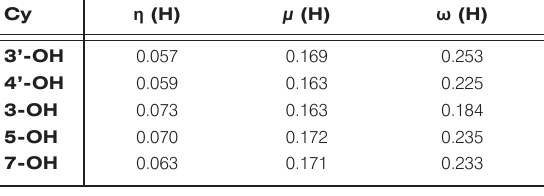
Table 9. Hardness, electronegativity and electrophilic index of delphinidin (HF/6-31+G(2d,p)). Dp η (H) μ (H) ω (H)